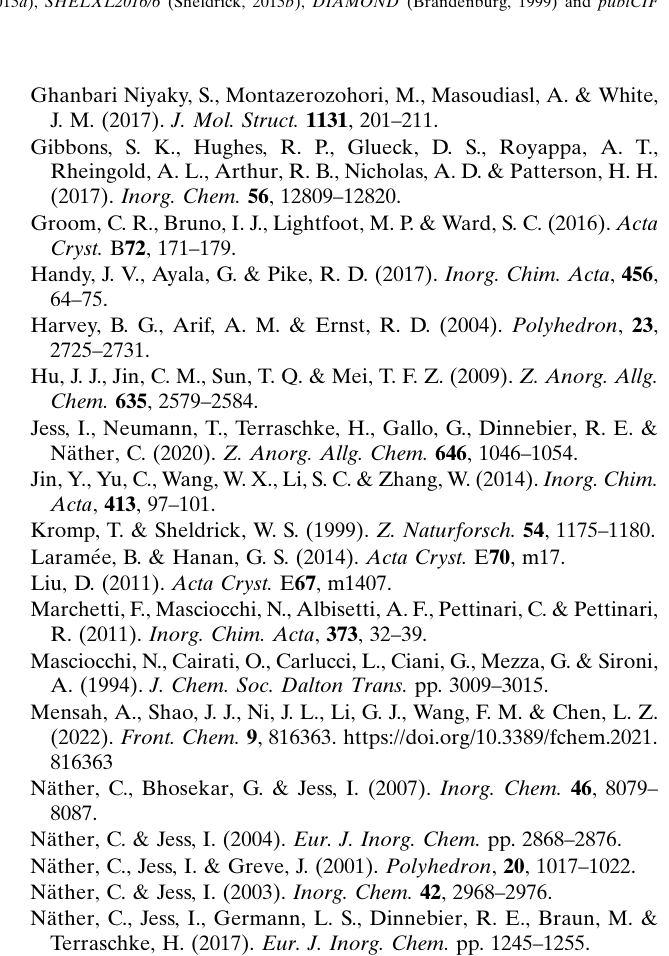
Crystal data Chemical